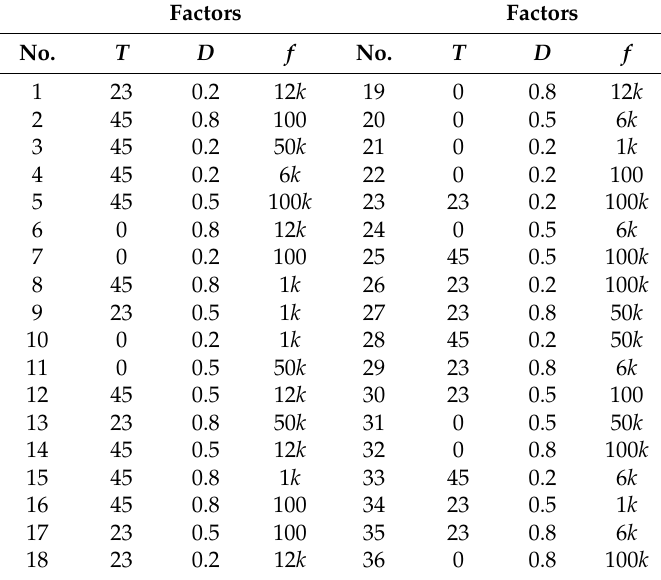
Table 3. Taguchi orthogonal